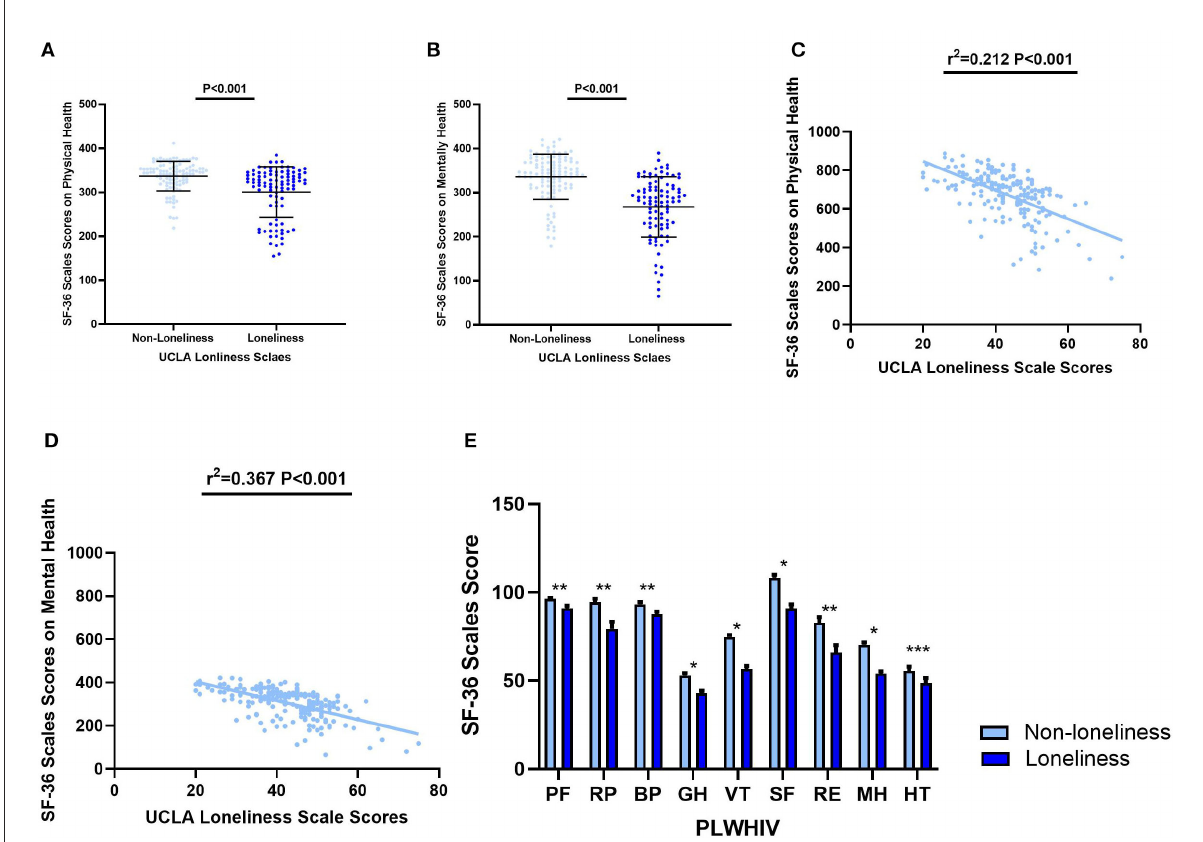
FIGURE3 Aspects of HRQoL in the loneliness and non–loneliness groups. (A) The SF − 36 Scale score on physical health of PLWHIV with loneliness were 336.85 ± 33.52, significantly higher than that without loneliness 300.70 ± 57.36 ( P < 0.001). (B) The SF − 36 Scale score on mental health of PLWHIV with loneliness were 335.95 ± 51.38, significantly higher than that without loneliness 267.44 ± 68.69 ( P < 0.001). (C) The SF − 36 Scale score on physical health was significantly and negatively co–related with UCLA Loneliness Scale scores. (D) The SF − 36 Scale score on mental health was significantly and negatively co–related with UCLA Loneliness Scale scores. (E) Eight aspects of SF − 36 Scale scores in two groups. * P < 0.001; ** P < 0.05; *** P > 0.05. Non–loneliness group vs. non–loneliness group: Mean ± SD. PF: 96.31 ± 6.67 vs. 90.96 ± 14.26; RP: 94.39 ± 20.98 vs. 79.26 ± 39.93; BP: 93.23 ± 11.95 vs. 87.52 ± 11.31; GH: 52.91 ± 14.64 vs. 42.96 ± 12.97; VT: 74.63 ± 12.32 vs. 56.70 ± 15.96; SF: 108.18 ± 18.34 vs. 90.82 ± 22.98; RE: 82.87 ± 31.51 vs. 65.96 ± 41.47; MH: 70.28 ± 14.90 vs. 53.96 ± 13.72; HT: 55.53 ± 25.11 vs. 48.67 ±